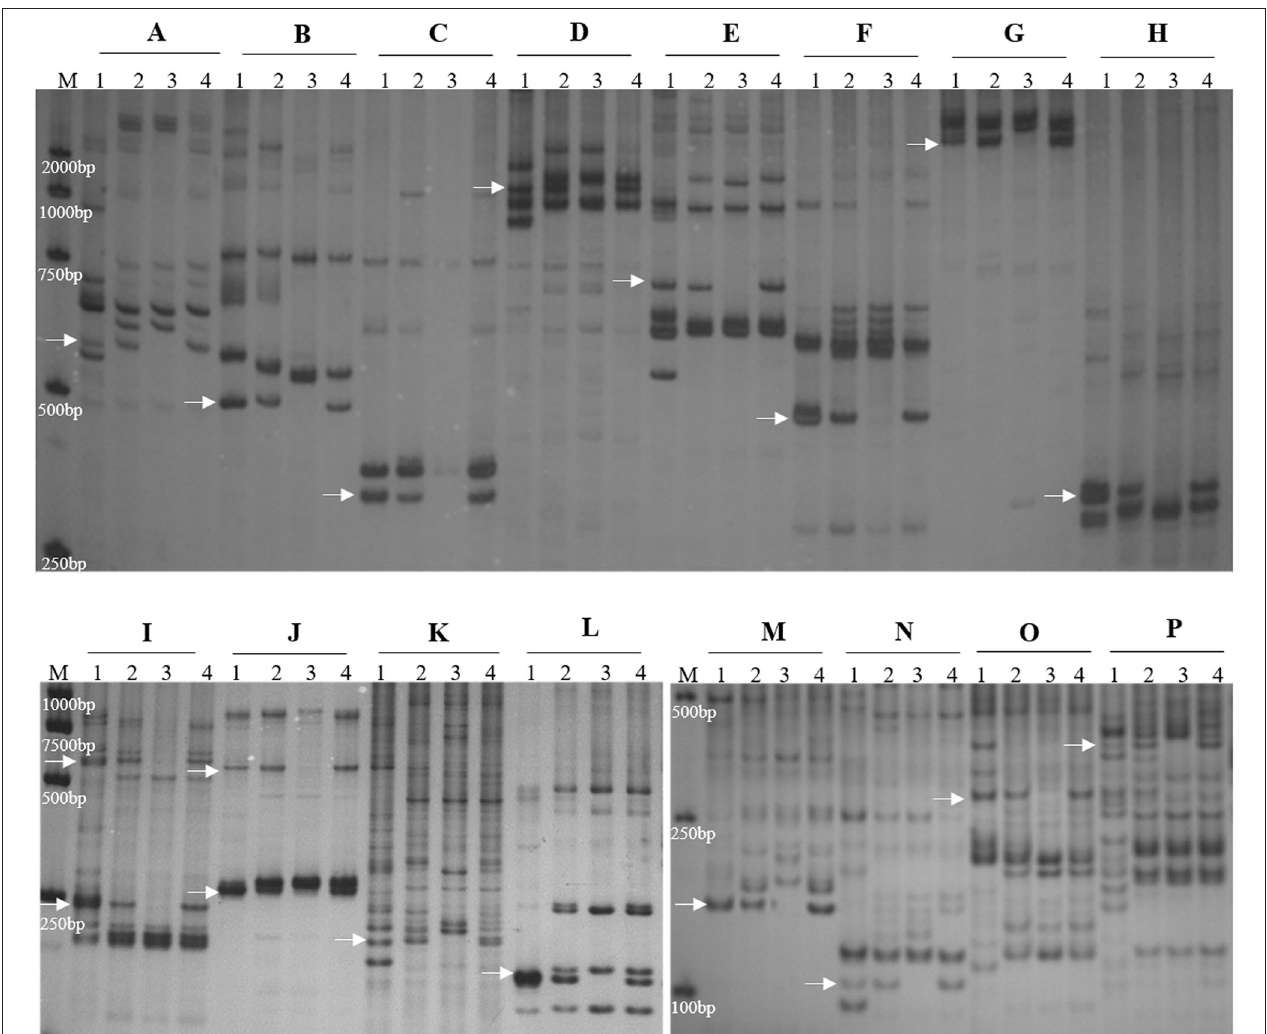
FIGURE 3 | Molecular marker analysis of SN19647. (A) CINAU851. (B) CINAU857. (C) CINAU859. (D) CINAU862. (E) CINAU865. (F) CINAU866. (G) CINAU870. (H) CINAU880. (I) CINAU889. (J) CINAU890. (K) CINAU971. (L) CINAU1616. (M) Xgwm268. (N) SWES650. (O) Xmag3030. (P) BE405232. Lanes: M, DL2000 marker; 1-4 refer to Th. ponticum , SNTE20, JM22, and SN19647, respectively. Arrows indicate the specific bands of Th. ponticum